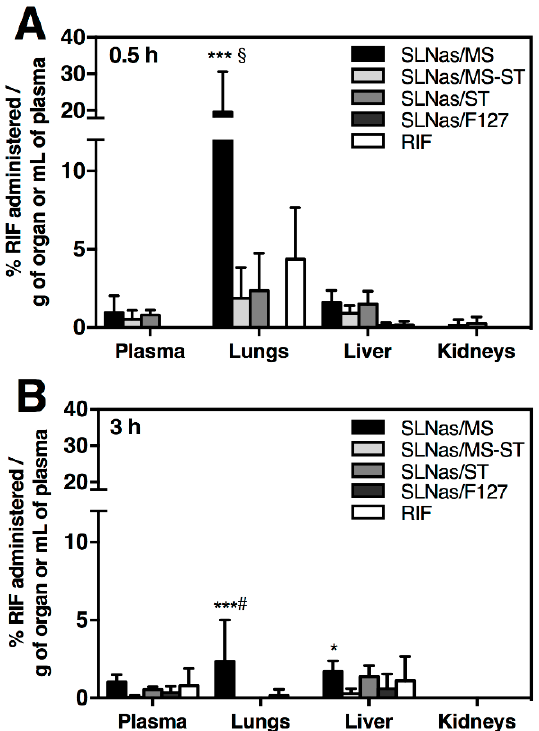
Figure 5. Quantification of RIF in plasma and tissue homogenates. Percentages of RIF dose per plasma volume or lung, liver, and kidneys weight (n = 4–6) at 0.5 h ( A ) and 3 h ( B ) after intratracheal administration of SLNas/MS, SLNas/MS-ST, SLNas/ST, SLNas/F127, and bare RIF. *** § p < 0.001 vs. SLNas/MS-ST, SLNas/ST, SLNas/F127, and bare RIF. *** # p < 0.001 vs. SLNas/MS-ST, SLNas/ST, SLNas/F127 and bare RIF. * p < 0.05 vs. SLNas/MS-ST.